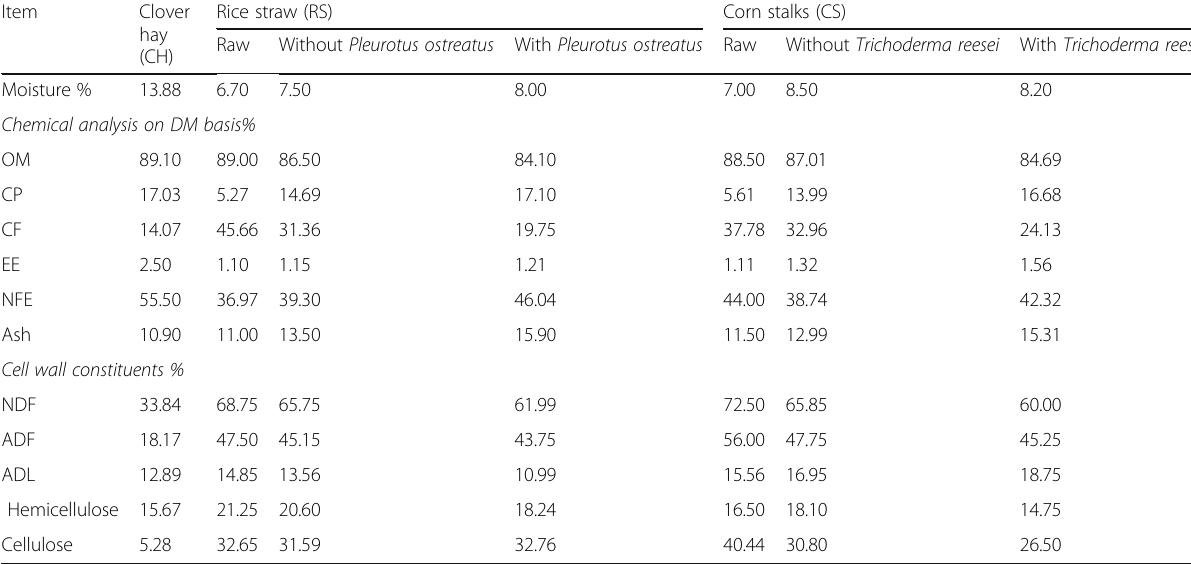
Table 1 Chemical analysis of different roughages used in ration formulations